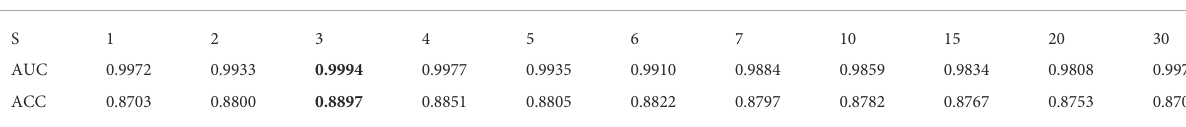
The best results are highlighted in